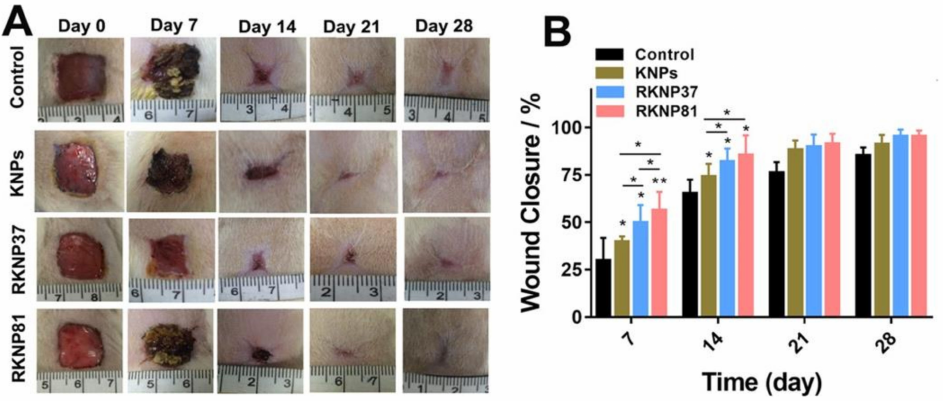
Figure 4. ( A ) Healing progression of full-thickness cutaneous wounds treated with RKNP37, RKNP81, and KNPs. ( B ) Rate of wound closure on days 0, 7, 14, 21, and 28. * p < 0.05, ** p < 0.01 relative to control group. Reprinted with permission from [35]. Copyright 2021 American Chemical Society.